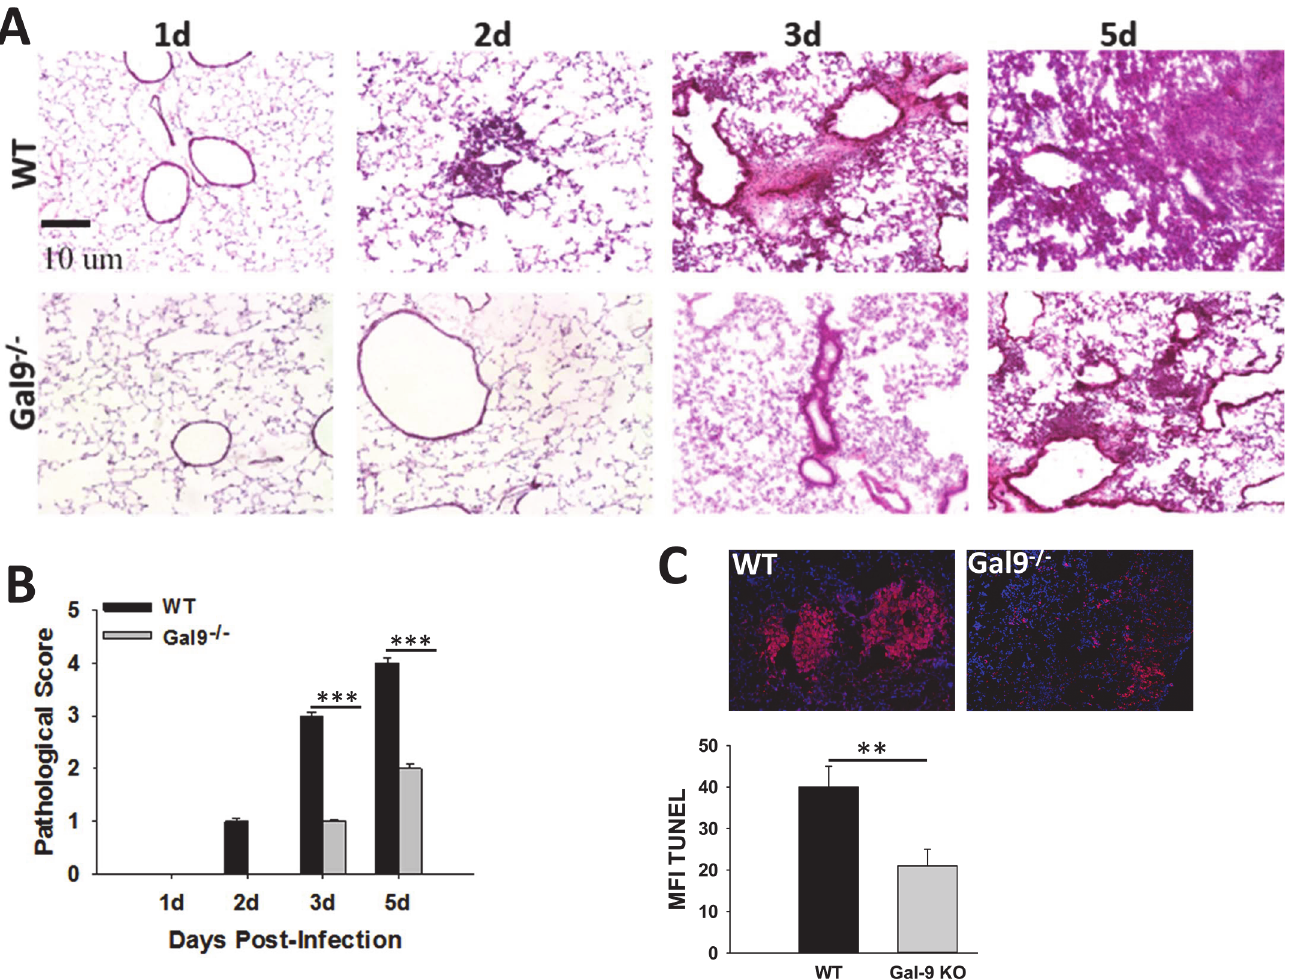
Fig 2. Gal-9 -/- mice exhibit improved lung pathology and reduced TUNEL staining indicative of cell death upon pulmonary F.n. infection. (A) The lungs from F.n. infected wild-type (WT) or Gal-9 -/- mice were harvested at indicated times post-infection, embedded in optimal-cutting-temperature (OCT) compound, and sectioned as described in Materials and Methods. The frozen sections were stained with Hematoxylin and Eosin (H&E). The images obtained are representatives of three experiments performed with 3 mice per group in each experiment. Magnification, ×200. (B) H&E sections were scored in blinded fashion according to the following scoring scale: 0, no inflammatory cells (macrophages or neutrophils) present in section; 1, < 5% of section infiltrated by inflammatory cells; 2, 5 – 10% of section infiltrated; 3, 20% of section infiltrate; and 4, > 20% of section infiltrated. (C) Frozen lung sections from F. n. infected WT or Gal-9 -/- mice were processed for in-situ TUNEL staining for detection of DNA fragmentation (red) in nuclei. Nuclei (blue) were stained with 4 0 ,6 0 -diamidino-2-phenylindole dilactate. Bar graph shows Mean fluorescence intensity (MFI) quantified using Image J software. Magnification,